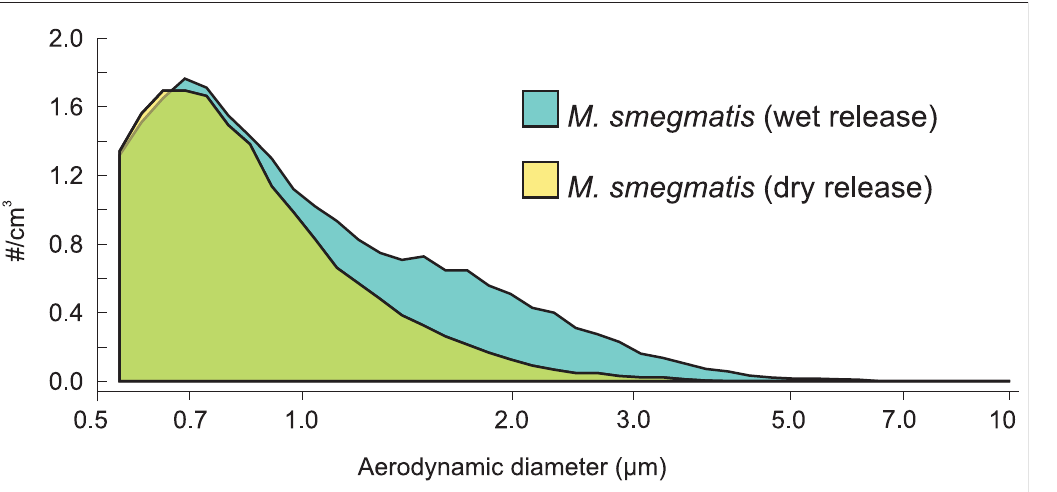
Fig 3. The effect of aerosol hydration on particle size distribution. The graph shows APS measurements of “ wet ” and “ dry ” releases of M . smegmatis :: gfp . (see text for